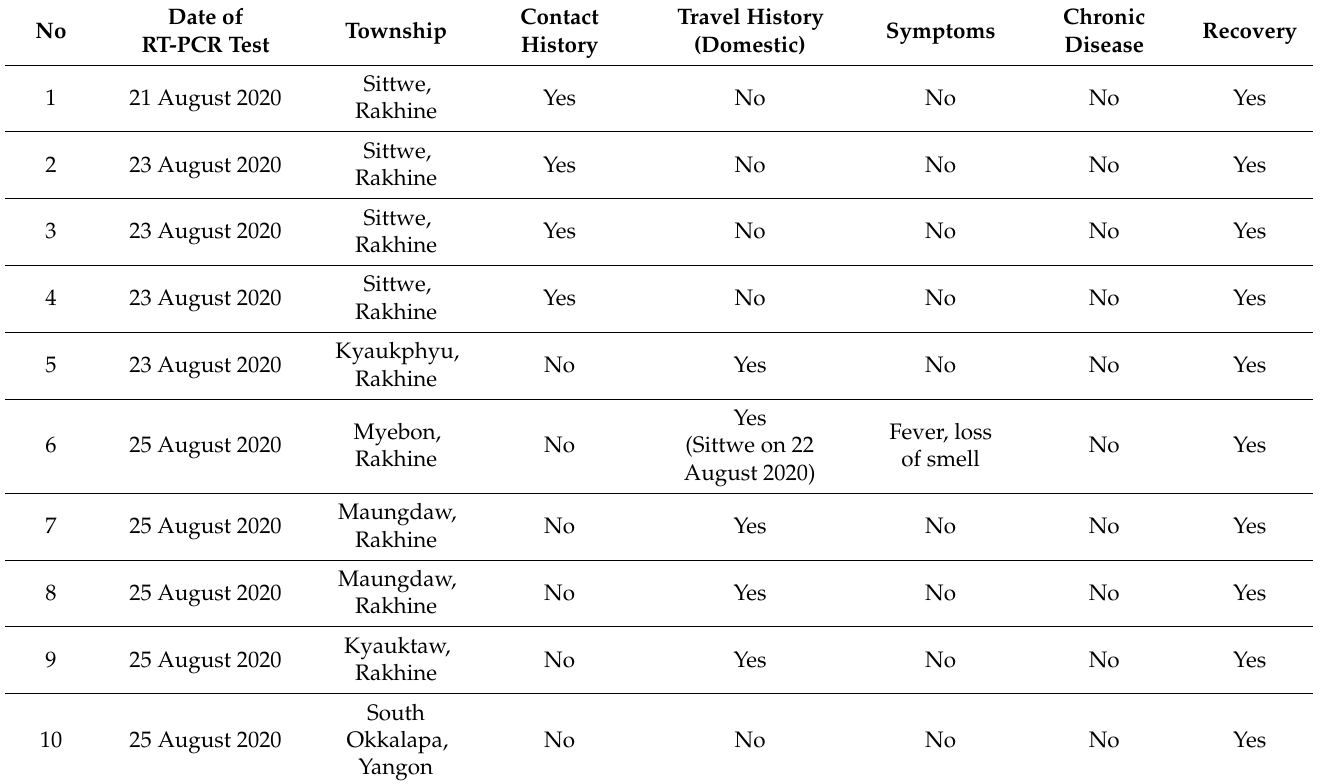
Table 1. Demographic characteristics of 10-COVID-19 patients in this